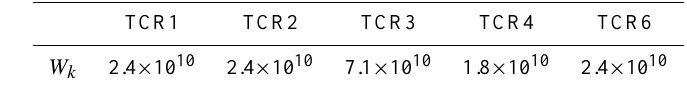
Table 2. Kinetic plasma energy W k in Joule per unit length of the reconnection line for the outflow regions associated with the investigated TCRs.